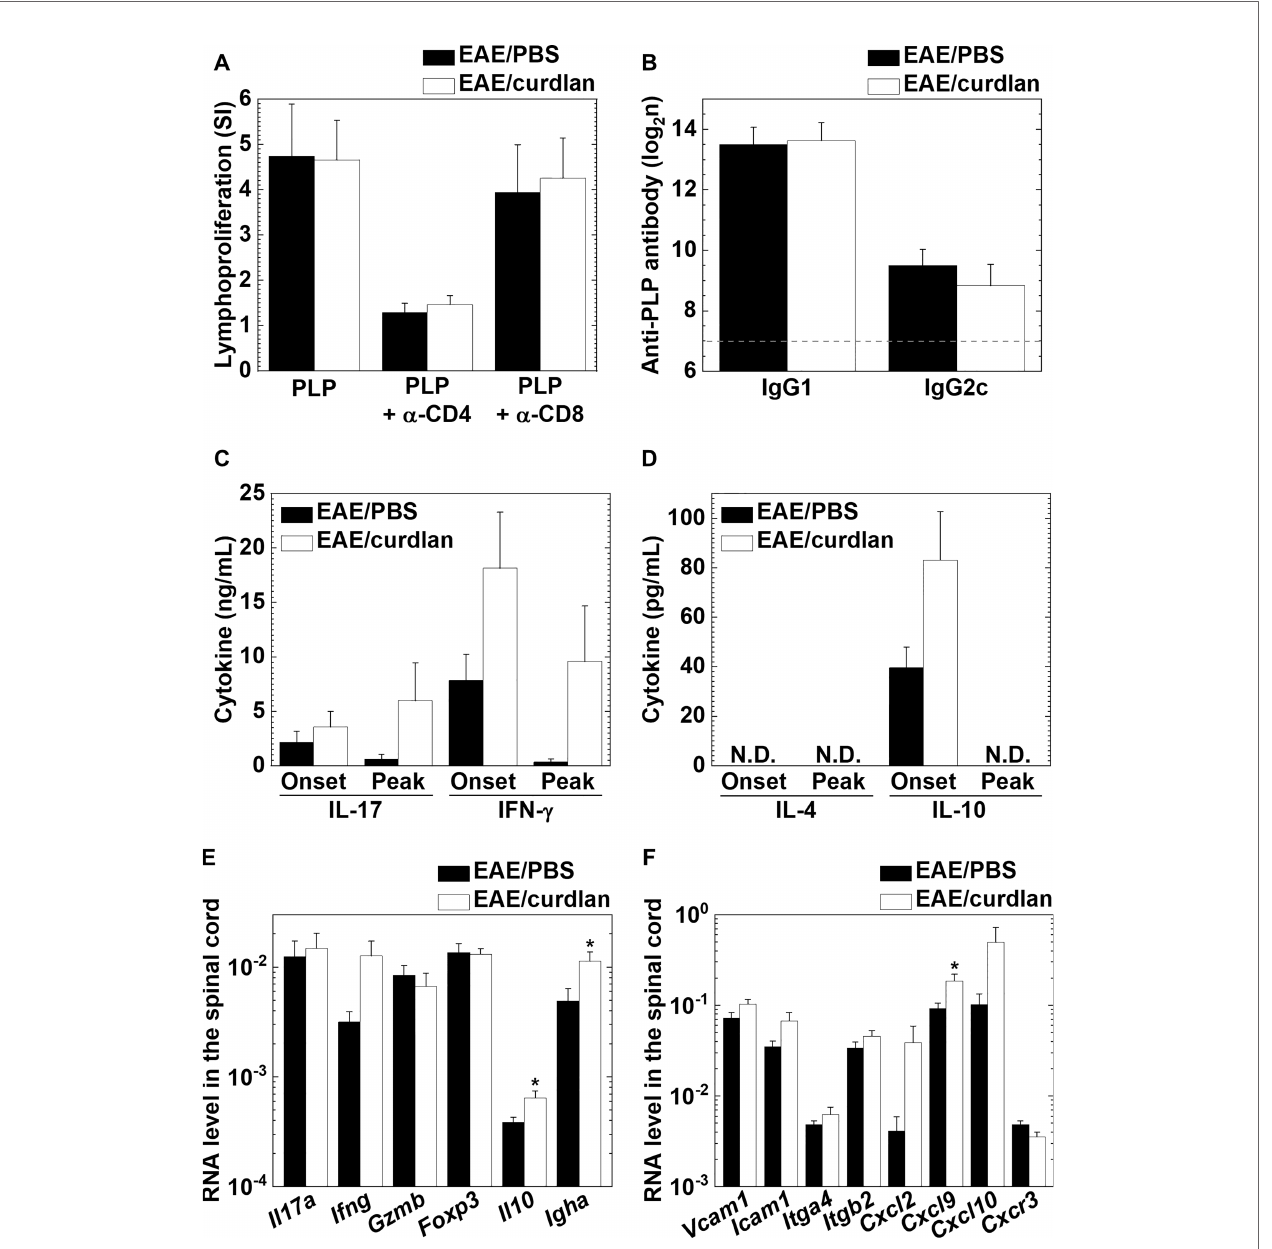
FIGURE 5 | Curdlan injection enhanced the production of interleukin (IL)-17 and interferon (IFN)- g , but not antigen-speci fi c lymphoproliferation or antibody responses in EAE. (A) PLP 139-151 -speci fi c lymphoproliferative responses of lymph node cells from the control (EAE/PBS, black bar) and curdlan-treated (EAE/curdlan, white bar) EAE mice a few days before the disease onset, 8 – 9 days post sensitization. Inguinal lymph node cells were stimulated with the PLP 139-151 peptide in the presence or absence of a blocking antibody against CD4 or CD8. Levels of lymphoproliferation were expressed as stimulation indexes (SI): (mean absorbance in PLP 139-151 stimulation)/(mean absorbance without stimulation). (B) Enzyme-linked immunosorbent assays (ELISAs) of serum anti-PLP 139-151 immunoglobulin (Ig) G1 and IgG2c antibodies in sera from the control EAE and curdlan-treated EAE mice 13 – 14 days post sensitization. The dotted line indicates the detection limit. (C, D) ELISAs of IL-17, IFN- g (C) , IL-4, and IL-10 (D) production from lymph node cells of the control EAE and curdlan-treated EAE mice harvested a few days before onset (Onset) or at the disease peak (Peak). Cells isolated from the inguinal lymph nodes were cultured with the PLP 139-151 peptide. The four cytokines in the culture supernatants were quanti fi ed using ELISA kits. N.D., not detectable. (E, F) Real-time polymerase chain reaction (PCR) analyses of T cell-related (E) and immune cell migration/ in fi ltration-related (F) genes in the spinal cord from the control and curdlan-treated EAE mice at the disease peak. Il17a (IL-17), Ifng (IFN- g ), Gzmb (granzyme B), Foxp3 (forkhead box P3, regulatory T cell marker), Il10 (IL-10), Igha (Ig heavy chain a , IgA marker), Vcam1 (vascular cell adhesion molecule 1), Icam1 (intracellular adhesion molecule 1), Itga4 (integrin a 4), Itgb2 (integrin b 2), Cxcl2 [chemokine (C-X-C motif) ligand 2, CXCL2], Cxcl9 (CXCL9), Cxcl0 (CXCL10, also known as IFN- g - inducible protein 10), and Cxcr3 [chemokine (C-X-C motif) receptor 3, CXCR3]. Pgk1 expression was used as a housekeeping gene for normalization. (A – F) Values are the mean + SEM from six to eight mice per group. * P < 0.05, Student ’ s t